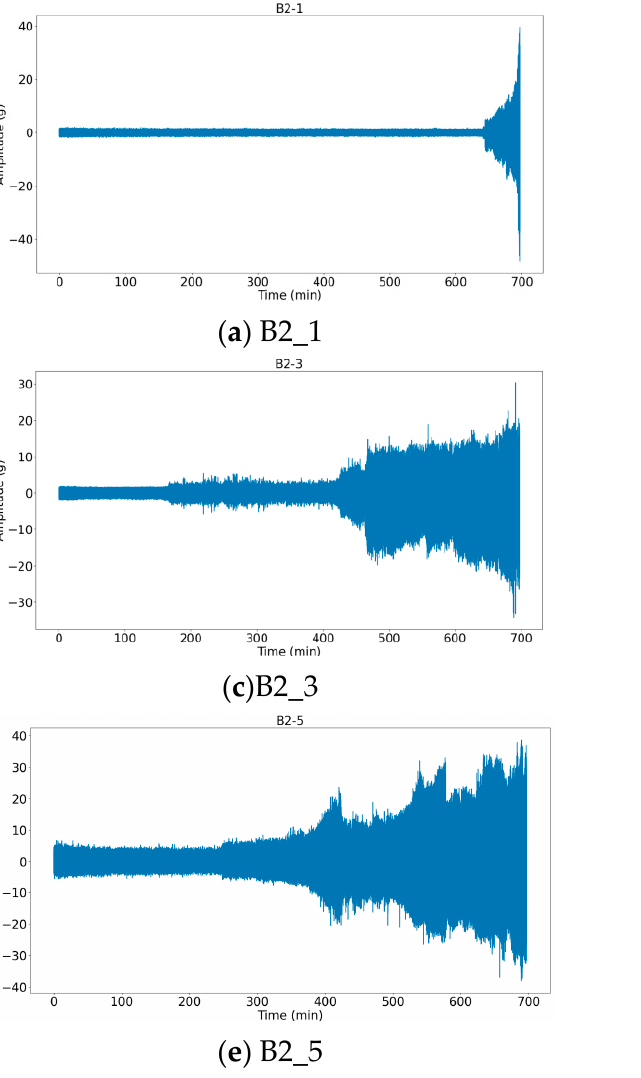
Figure 7. Time-domain data curves of bearing performance under working condition 2.